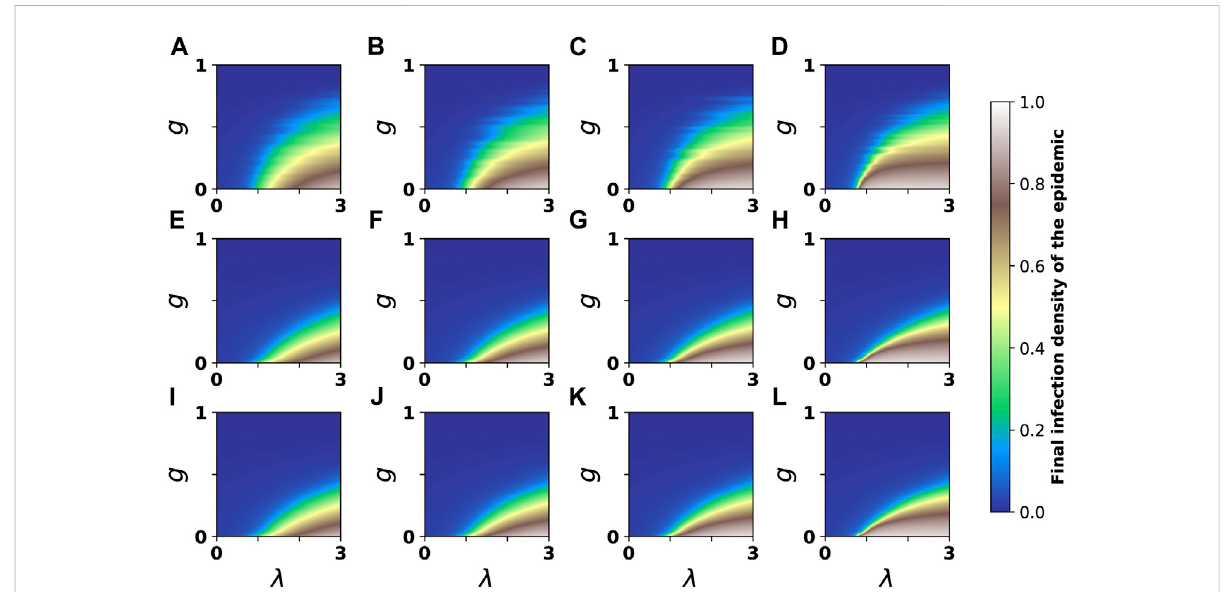
FIGURE 4 Evolution of the fi nal infection density with λ and g under varying 2-simplex infection rates. g represents the ratio of immune nodes. Colors indicate theoretical results for fi nal infection density. Four subgraphs (A – D) at the top represent random immunization strategy, four subgraphs (E – H) in the middle represent the maximum degree immunization strategy, and four subgraphs (I – L) at the bottom represent the maximum betweenness immunization strategy. From the left to the right, λ * corresponds to 0.5, 3.5, 6.5 and